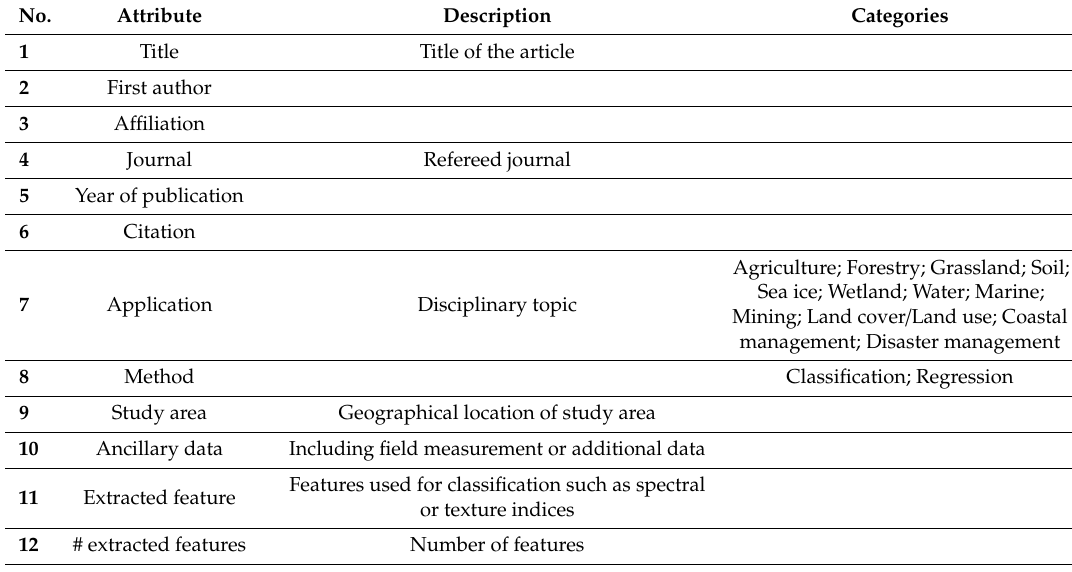
Table A1. Parameters cataloged in the